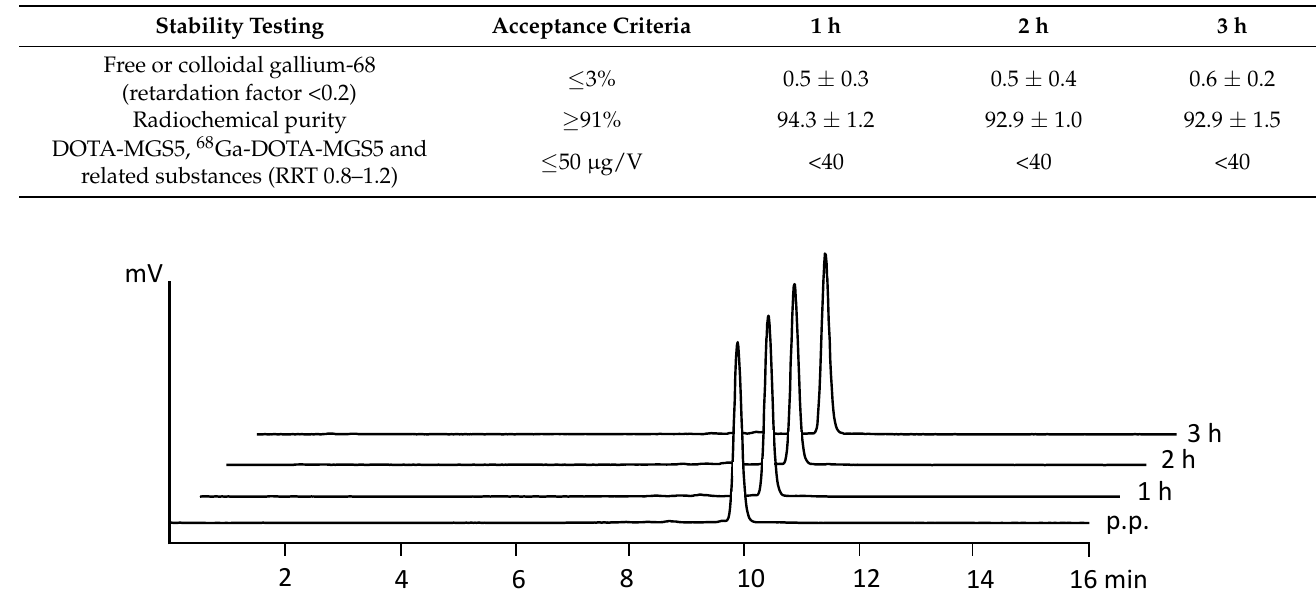
Table 2. Stability testing of 68 Ga-DOTA-MGS5 up to 3 h after preparation.